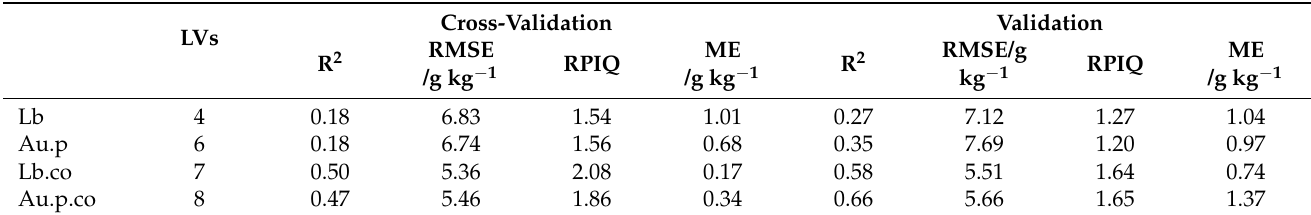
Table 3. The statistics of the cross-validation and prediction results of kriging for SOM.